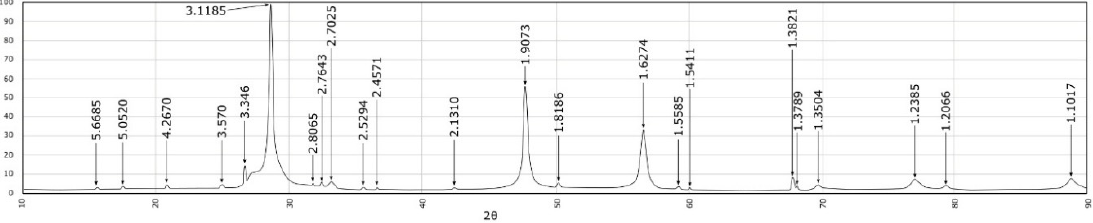
ff raction (XRD) of colloform sphalerite Figure 9. X-ray diffraction (XRD) of colloform sphalerite (Coll-Sph). Figure 9. X-ray di